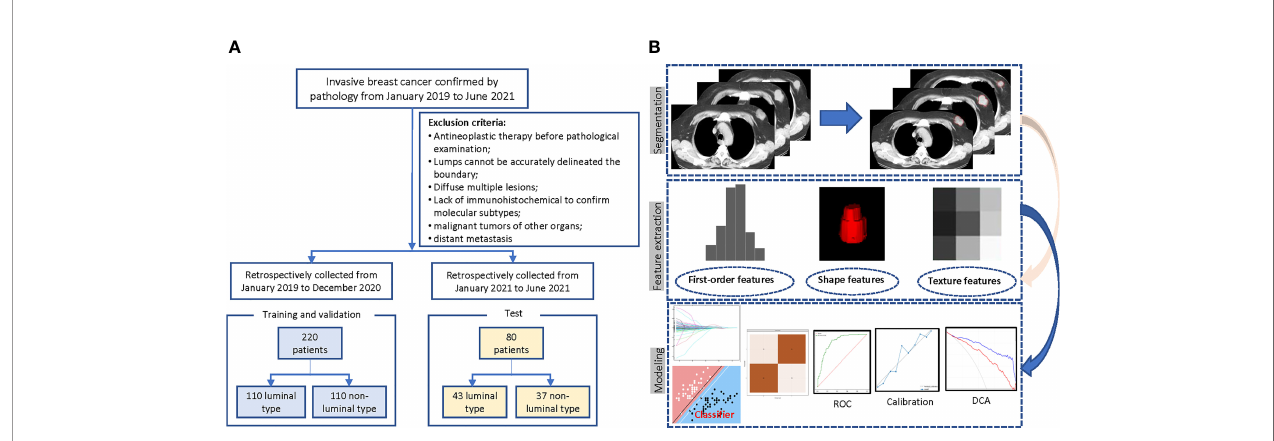
FIGURE 1 | Flowchart of the patient selection and study design. (A) Case screening and division of training and test set. (B) The radiomics work